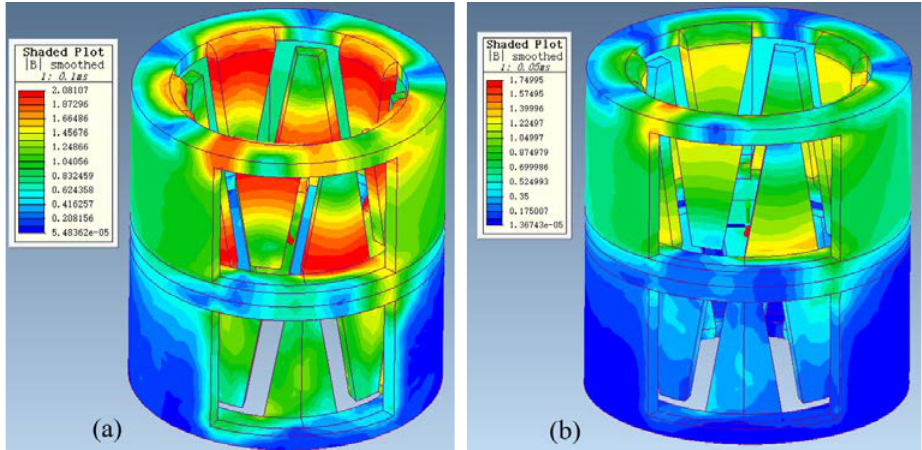
Figure 10. ( a ) Magnetic density cloud map under 0.10 mm air gap ( left ); ( b ) Magnetic density cloud map under 0.30 mm air gap ( right ).